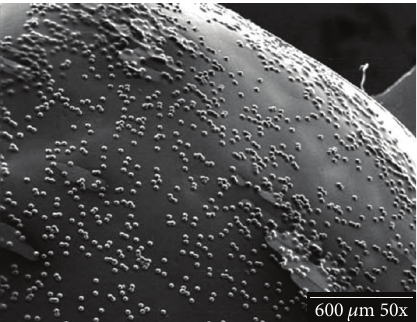
Figure 3: A color image of a bead film taken under blue light and a green bandpass filter. The film provides a dark background allowing direct imaging over the fluorescing enamel.